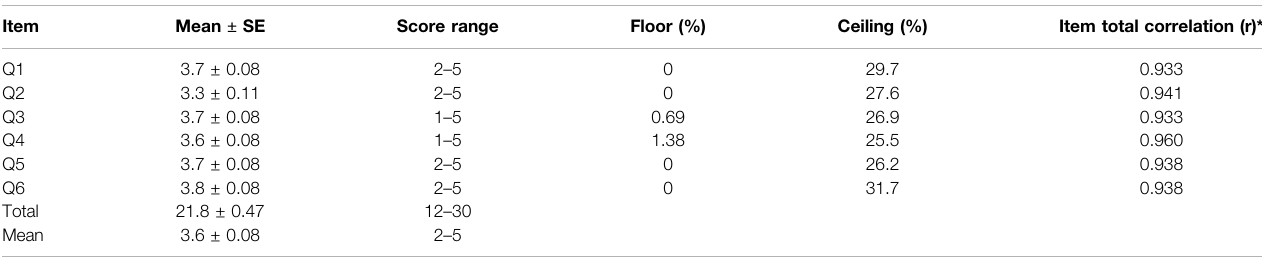
TABLE 3 | Characteristics of the questionnaire used in this study ( n (cid:1)